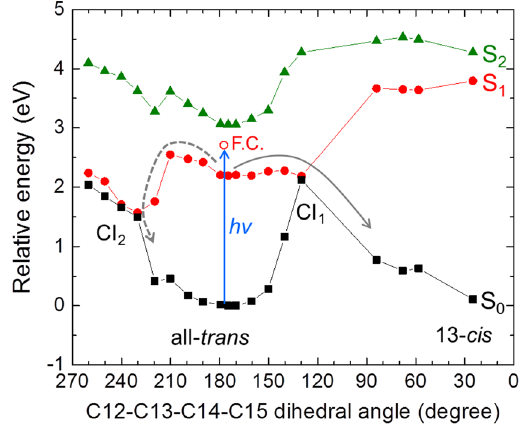
Figure 4. CASPT2//CASSCF(12,12) photoisomerization pathways from the all- trans retinal conformer, when the retinal Schiff base is hydrogen-bonded to Glu162. S 0 (black closed squires with black solid line), S 1 (red closed dots with red solid line) and S 2 (green closed triangles with green solid line) energy profiles are shown. The blue arrow shows light excitation of all- trans retinal as performed on our pump-probe and pump-dump-probe spectroscopic experiments. The open red dot shows the Franck–Condon state (F.C.) The solid gray arrow shows the isomerization path through energy barrier of 1.96 kcal/mol (0.09 eV) on S 1 via a conical intersection CI 1 . The dashed gray arrow indicates a relaxation path through energy barrier of 7.42 kcal/mol (0.32 eV) on S 1 via another conical intersection CI 2